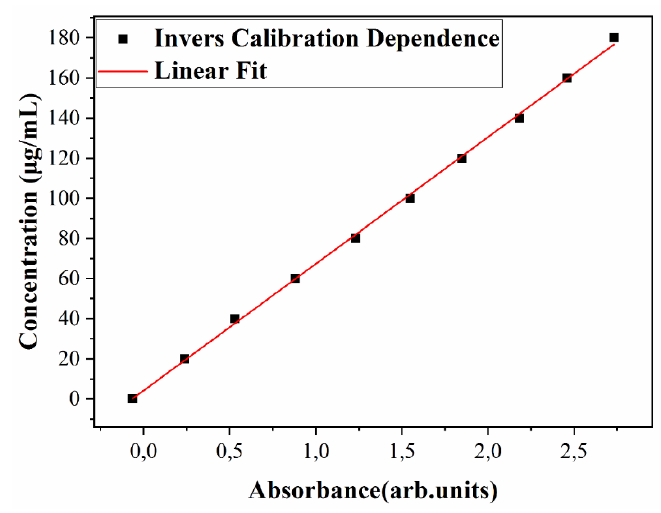
Figure 15. Inverse calibration dependence, c(A).